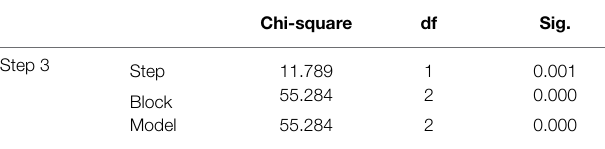
TABLE 10 | Omnibus tests of model